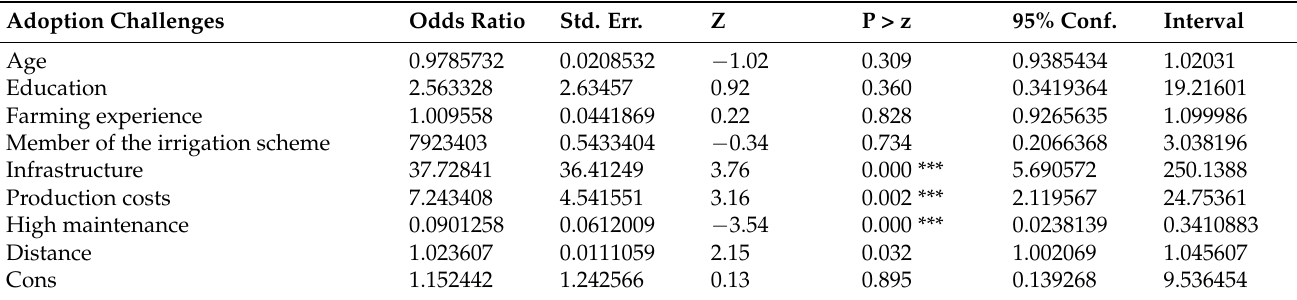
Table 10. Logit regression results for the adoption